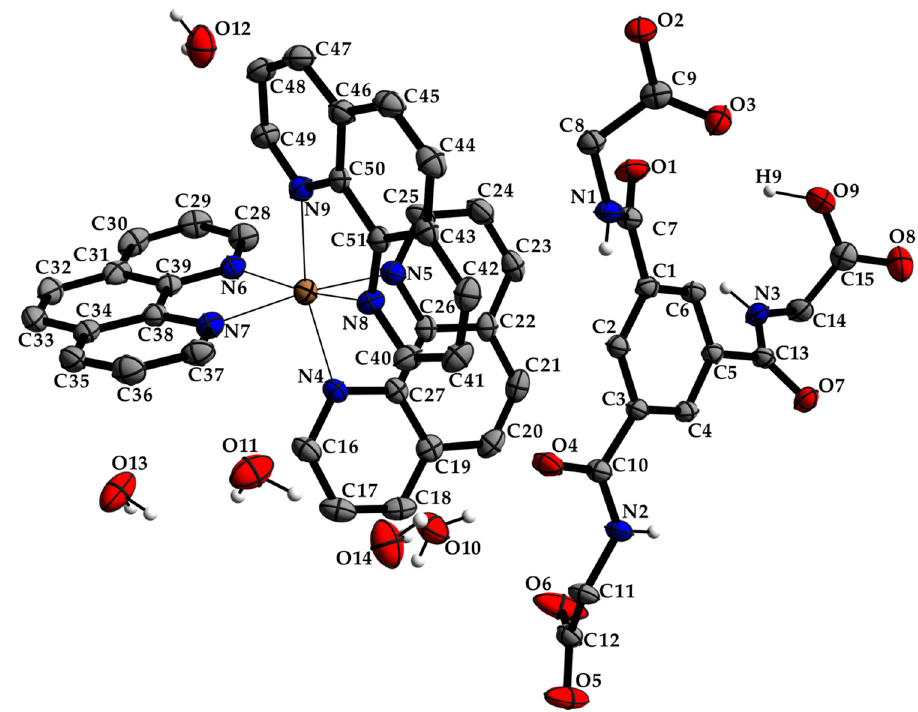
Figure 1. The molecular entities of the zinc(II) complex and the dianion as well as water molecules with atom labels and displacement ellipsoids of non-H atoms drawn at the 40% probability level. The hydrogen atoms of the carbons have been omitted for clarity (see Tables S1 and S2 for details).